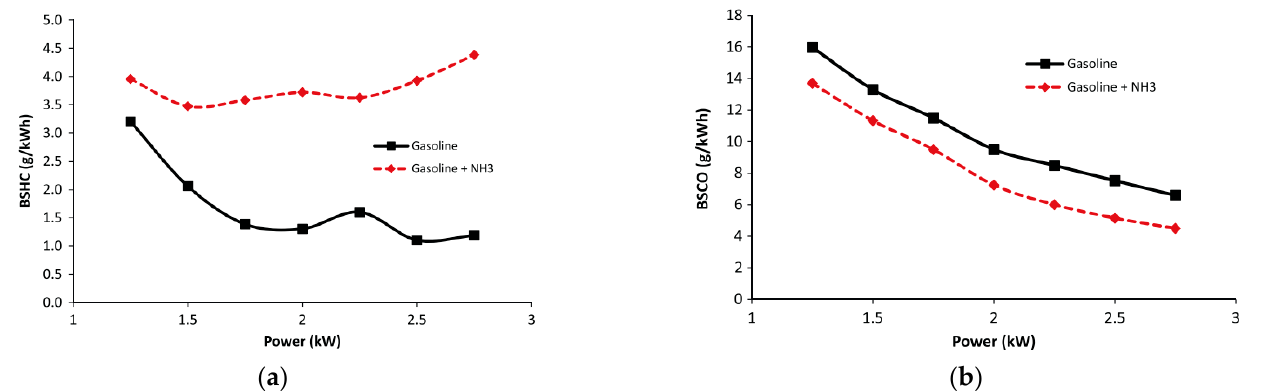
Figure 8. Comparison of emissions at different power levels: ( a ) HC emissions; ( b ) CO emissions.